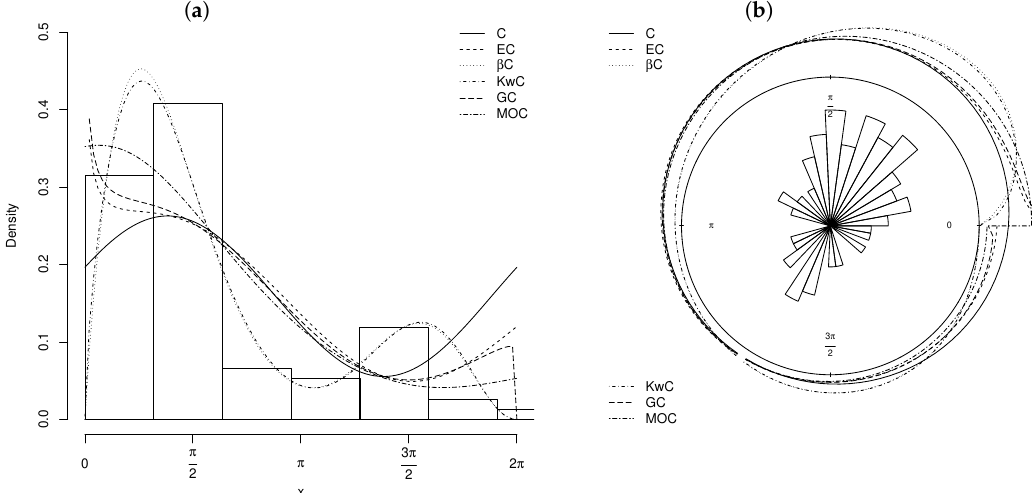
Figure 7. Fitted densities of the C, EC, β C, KwC, Γ C, and MOC models to the second dataset. ( a ) histogram and ( b ) rose